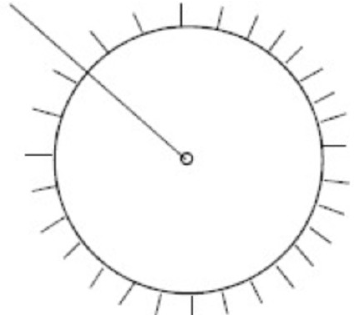
Figure 33 . The wave functions for the strings 1 and 3 by the functional integral of following (cid:12)gure as a disc or a half in(cid:12)nite